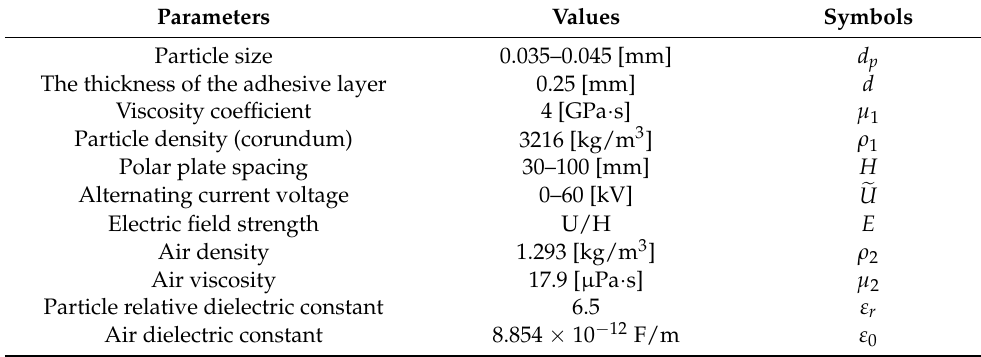
Table 2. Field model